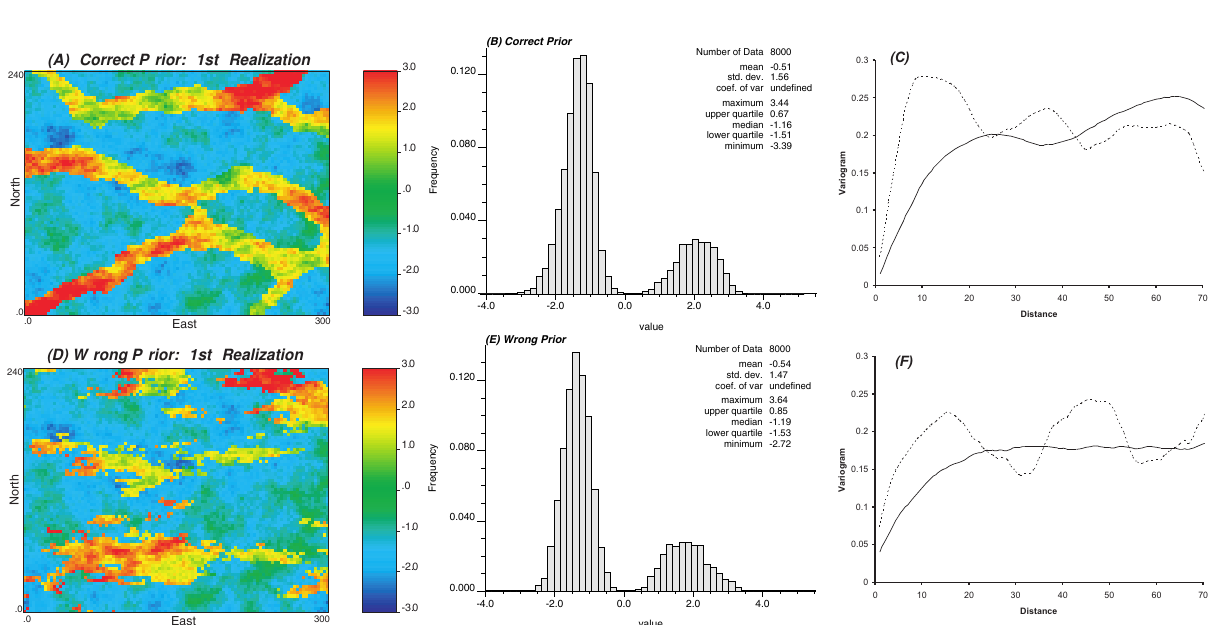
Fig. 4. (A–C) show the spatial distribution of ln K , histogram and variogram of the 1st realization from the correct prior model; (D–F) show the same characteristics of the 1st realization from wrong prior model. In (C) and (F) , solid line and dotted line correspond to the experimental facies variogram in X and Y direction, respectively.